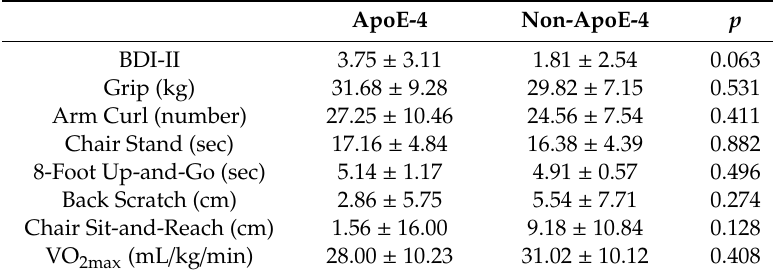
Figure 2. Time–frequency decomposition with Morlet wavelets in the frontal region (Fz). Stimulus- locked rescaled oscillatory power averaged across midfrontal region stimulus in ApoE-4 and non- ApoE-4 groups. The results revealed that the non-ApoE-4 group showed significantly greater decreases in electroencephalogram (EEG) power at the alpha band (9–13 Hz) in the 4-item condition relative to the ApoE-4 group at approximately 250–550 ms following target onset (all p < 0.01, uncorrected). 3.4. Molecular Biomarkers As shown in Table 2, there were no significant differences (all p > 0.05) at the group level with regard to any molecular biomarkers (e.g., IL-1 β , IL-6, IL-8, BDNF, A β 1-40, A β 1-42) in the ApoE-4 and non-ApoE-4 groups. Table 2. Biochemical values (mean ± SD) of the ApoE-4 and non-ApoE-4 groups. ApoE-4